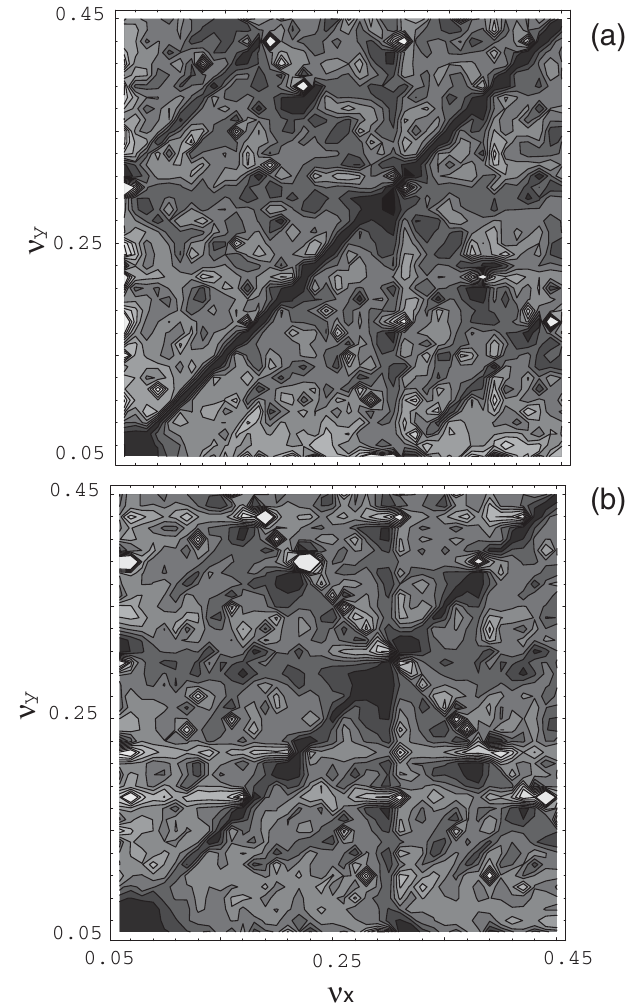
FIG. 18. Diffusion rate in transverse tune space. Plots (a) and (cid:5) 0 and (cid:8) (cid:5) 0 : 006 , respectively. The (b) are given for (cid:8) s s contour lines are drawn every D (cid:5) 1 (cid:2) 10 (cid:1) 5 , and the area labeled white is the highest rate, D (cid:5) 1 (cid:2) 10 (cid:1) 4 in plot (a). The lines are drawn every D (cid:5) 3 (cid:2) 10 (cid:1) 5 , and the area labeled white is the highest value, D (cid:5) 3 (cid:2) 10 (cid:1) 4 in plot (b).